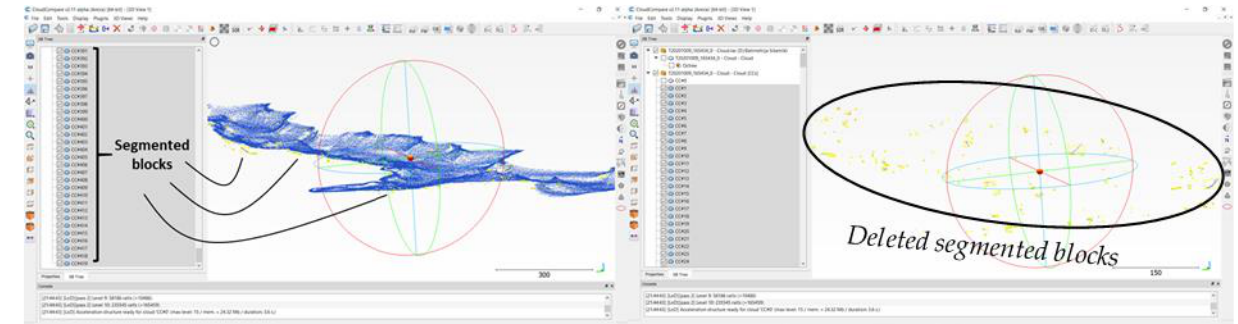
Figure 14. An example of dense point cloud filtering using the segmentation method ( LabelConnected components ).